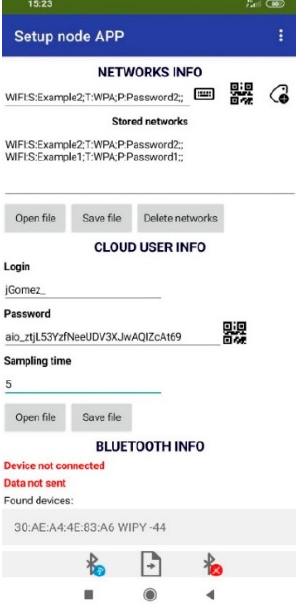
Figure 10. APP designed for setup procedure of the nodes.